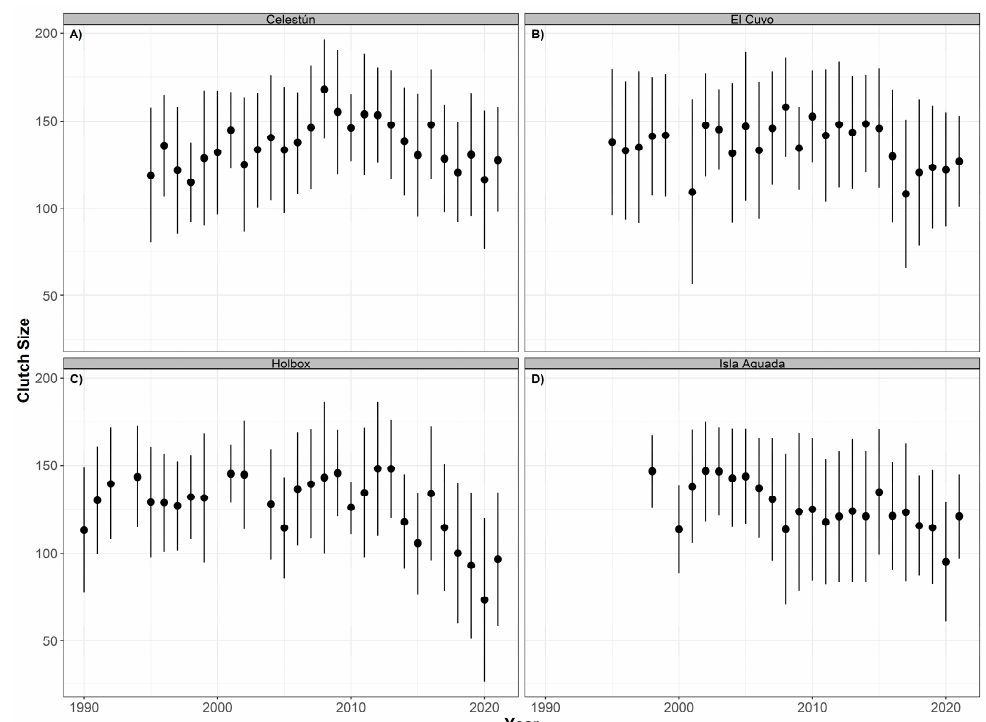
Figure 6. Time series of clutch size (annual mean ± SD) for hawksbill turtles ( Eretmochelys imbricata ) nesting at Celestún ( A ), El Cuyo ( B ), Holbox ( C ), and Isla Aguada ( D ) from 1990 to 2021. No significant trends were detected in green turtles ( p > 0.05, R 2 = 0.057) either. The